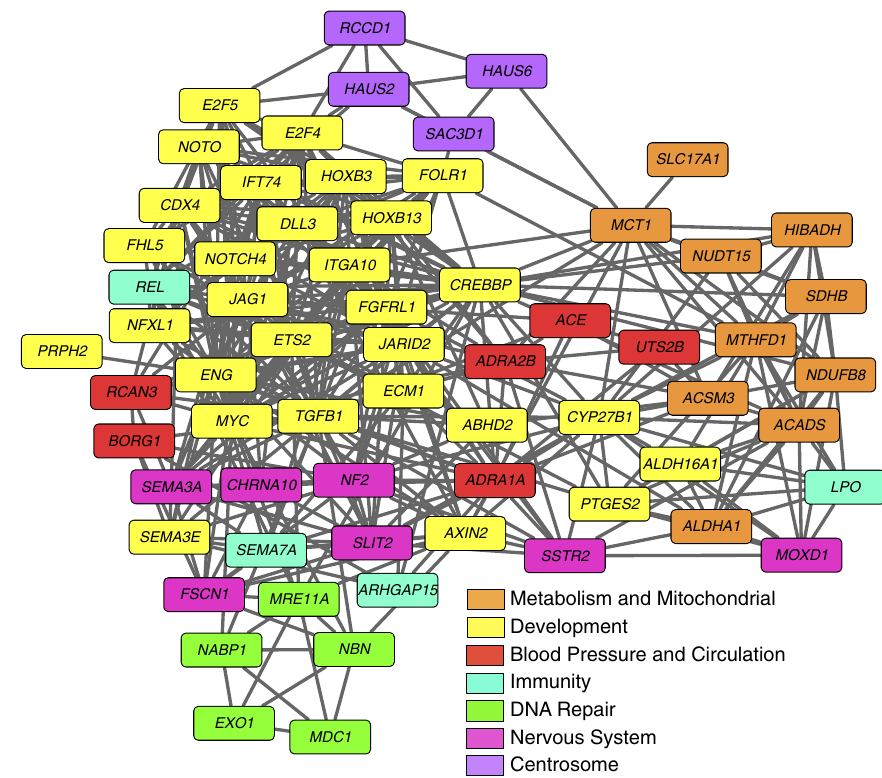
Figure 2 | Network analysis of GO biological process of giraffe MSA genes. Seventy genes were identified that exhibited MSAs based on amino acid sequence divergence as evaluated by neighbour-joining phylogenetic analysis of mammalian orthologous proteins, enrichment of nonsynonymous substitutions, unique amino acid substitutions at sites otherwise fixed in mammals, substitutions predicted to cause functional changes by Polyphen2 analysis and substitutions under positive selection. Cluster analysis was performed on the set of 70 giraffe MSA genes based on GO Biological Process using Cytoscape 3.0 (ref.